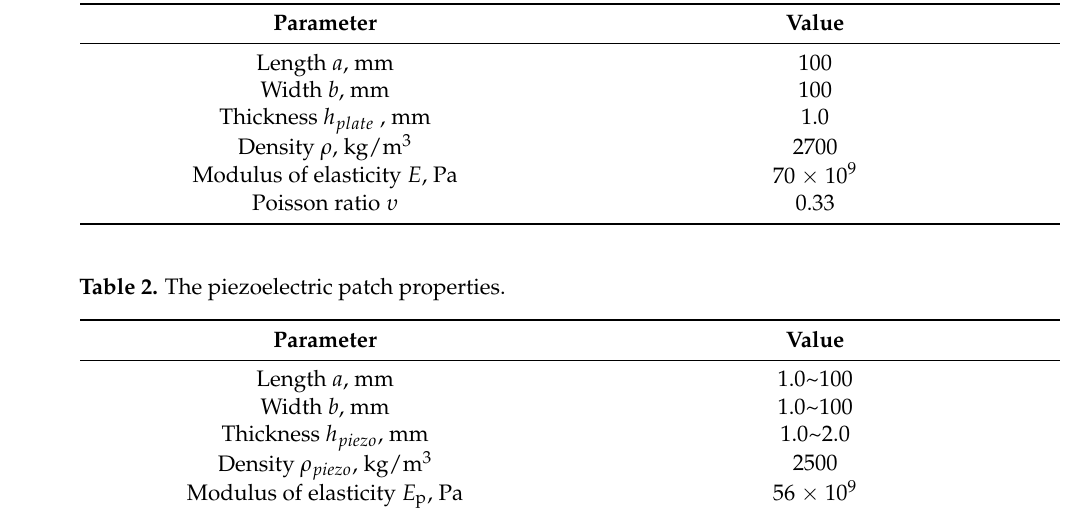
Table 1. Plate specifications.